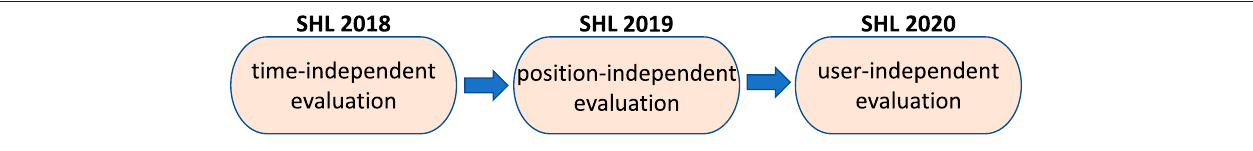
FIGURE 4 | Evolution of the three SHL challenges, which focused on time-independent, position-independent and user-independent evaluation,